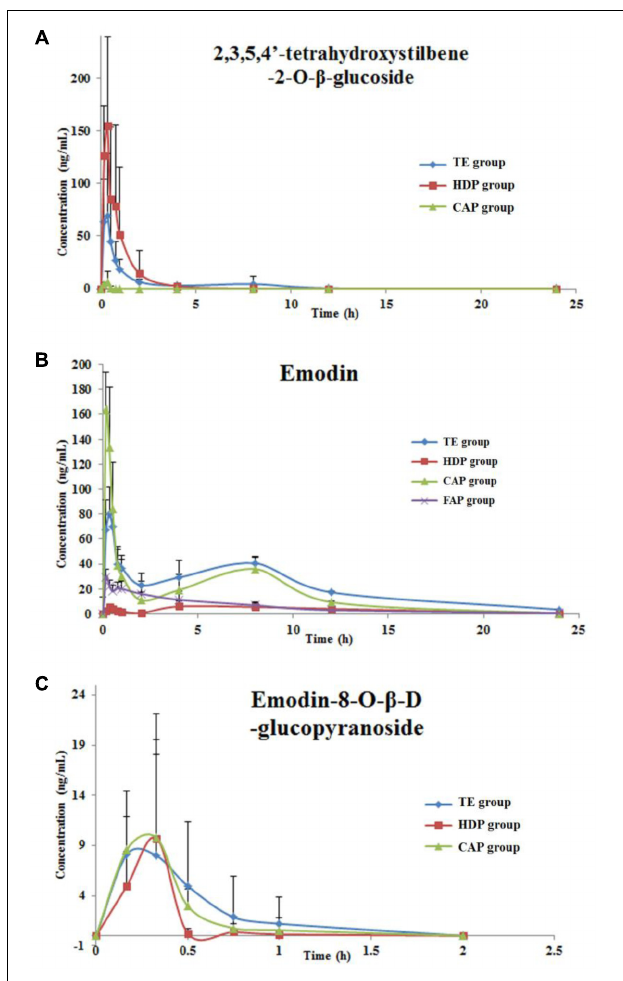
FIGURE 5 | The mean ( ± SD) plasma concentration–time profiles of TSG (A) , emodin (B) and EDG (C) in rats after oral